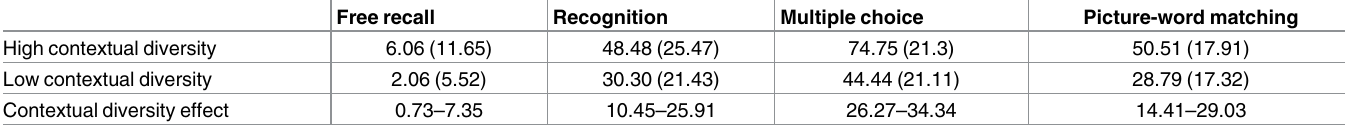
Table 3. Mean percent correct and standard deviations (in parentheses) of the four evaluation instruments for high contextual and low contextual diversity, together with the 95% confidence intervals for the contextual diversity